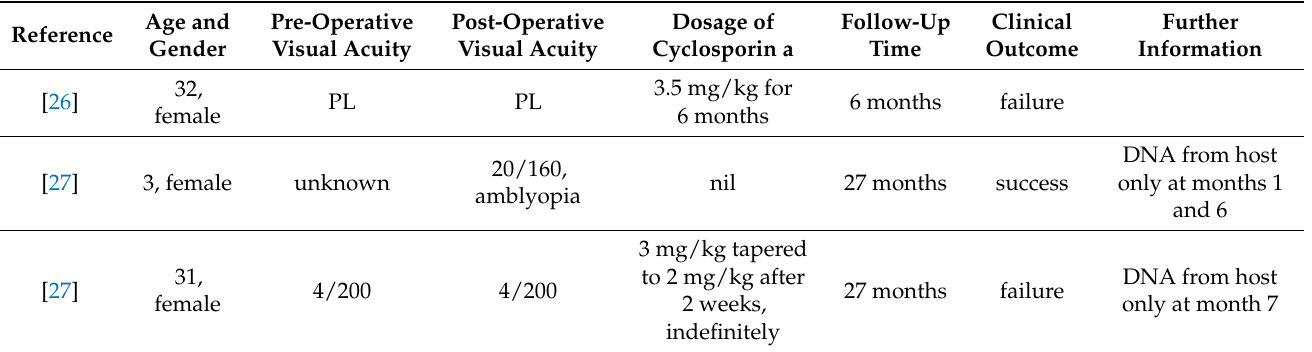
Table 2. Characteristics, treatments and clinical outcomes of patients with EEC syndrome/ectodermal dysplasia undergoing